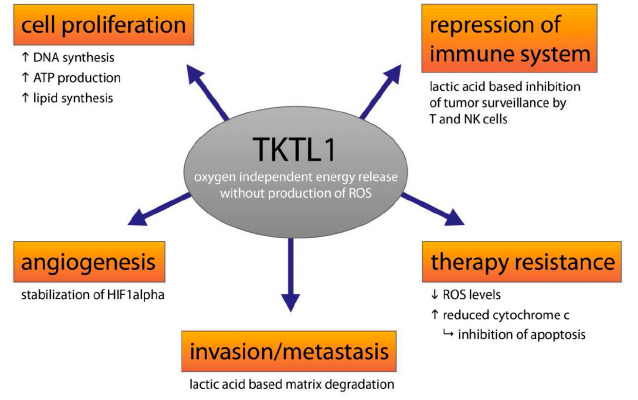
Figure 2. Role of TKTL1 in cancer cells. Contribution of TKTL1 and its metabolites to important hallmarks of cancer leading to increased malignity, survival, immune escape, therapy resistance and distribution of cancer cells in the body. “arrow up” indicates increase, arrow down indicates decrease.